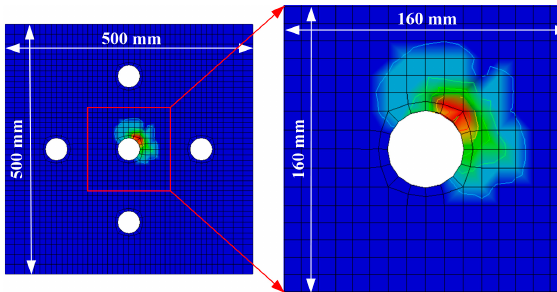
Figure 10. Effective stress contours of the front face of a rock containing five holes at the time of 0.1 s.